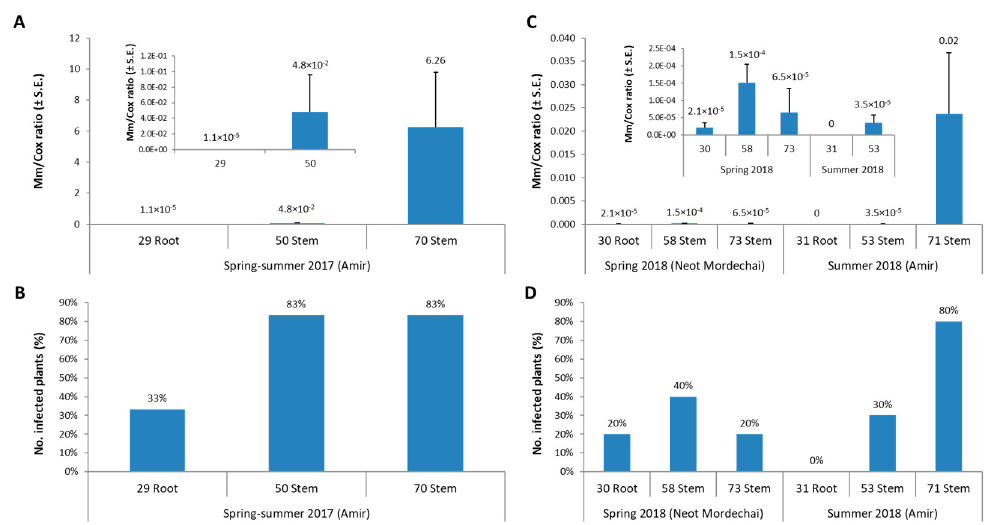
Figure 10 . Comparison of qPCR diagnosis of late-wilt pathogenesis. Molecular qPCR tracking of the M. maydis DNA at the control treatments in both the spring and summer 2018 field experiments (conducted here, C , D ) compared to the 2017 field experiment results (conducted at the same site) published earlier [37] ( A , B ). The y-axis (in A , C ) indicates H. maydis proportionate DNA abundance normalized to the cytochrome c oxidase ( COX ) DNA. Bars represent a mean of 10 replicates. Standard errors are indicated in error bars.